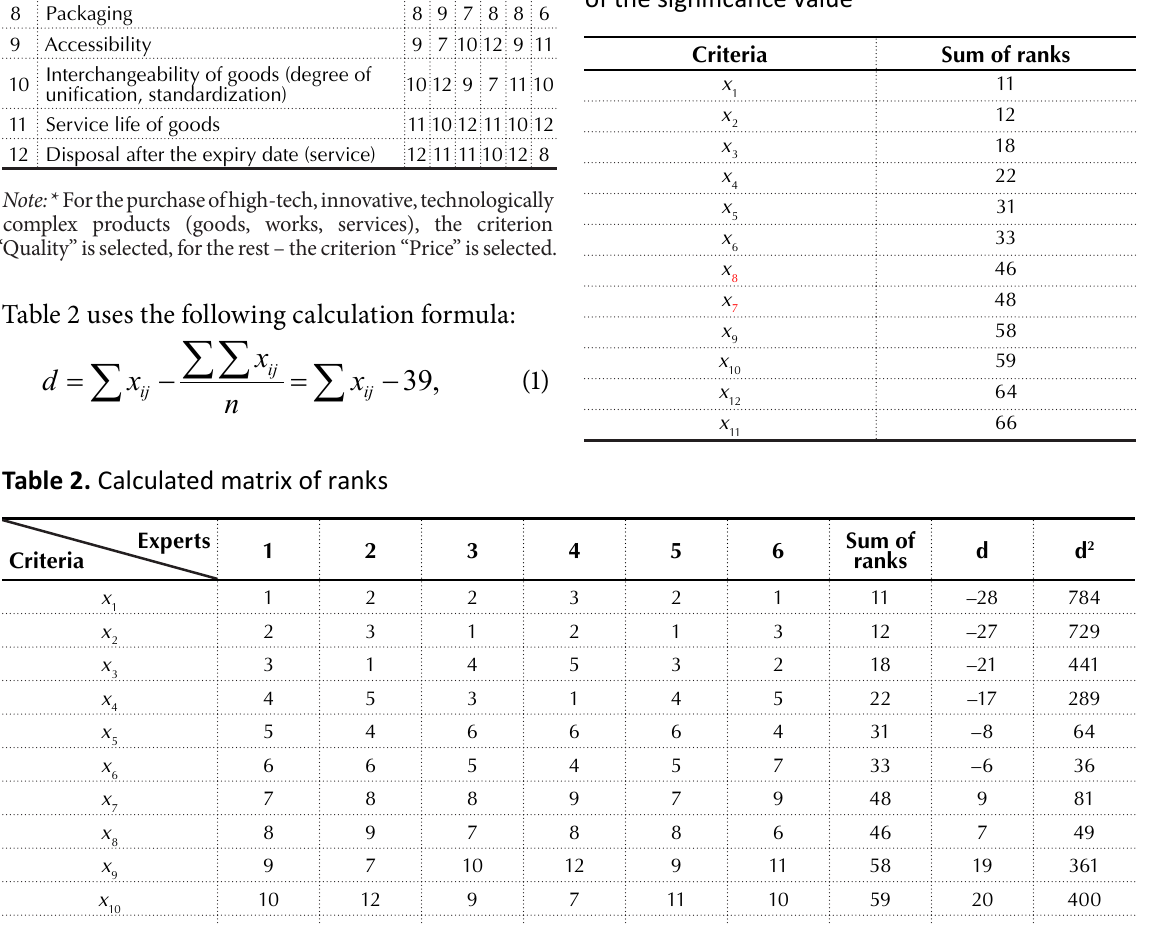
Table 3. Distribution of the criteria in order